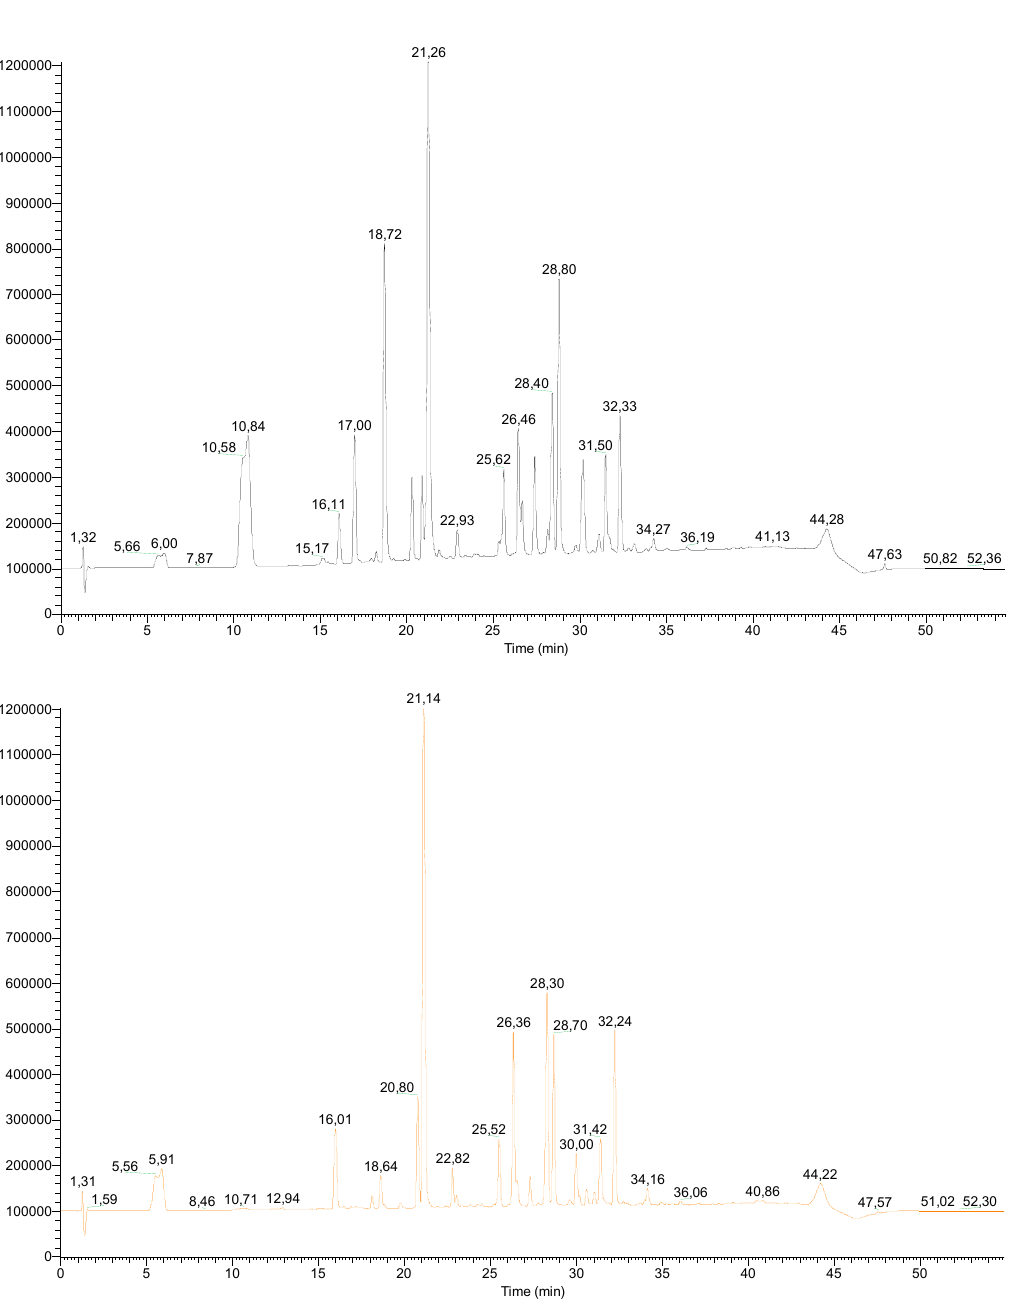
Figure 2. HPLC-UV chromatogram of an oakmoss absolute before (top) and after (bottom) HRP treatment (atranol and chloroatranol are eluting at 17.0 and 20.5 min, respectively).